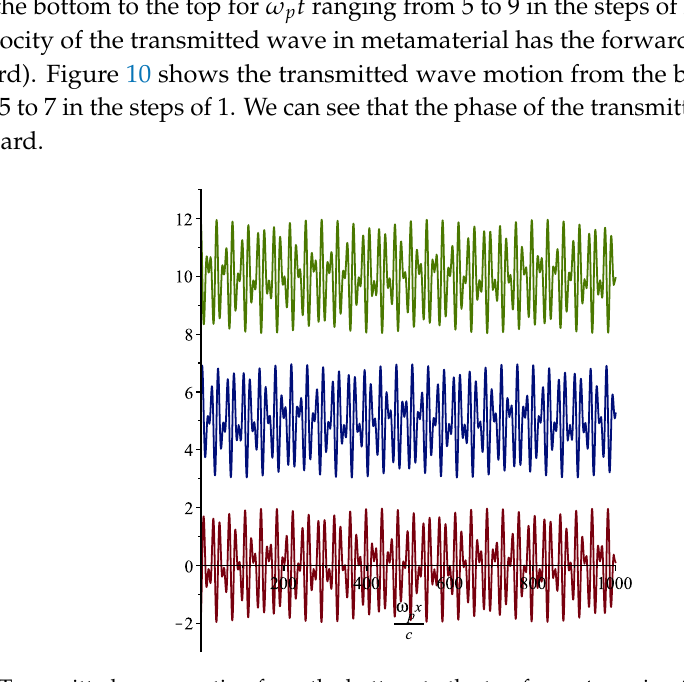
Figure 9. Transmitted wave motion from the bottom to the top for ω p t ranging from 5 to 9 in the steps of 2. The group velocity has the forward